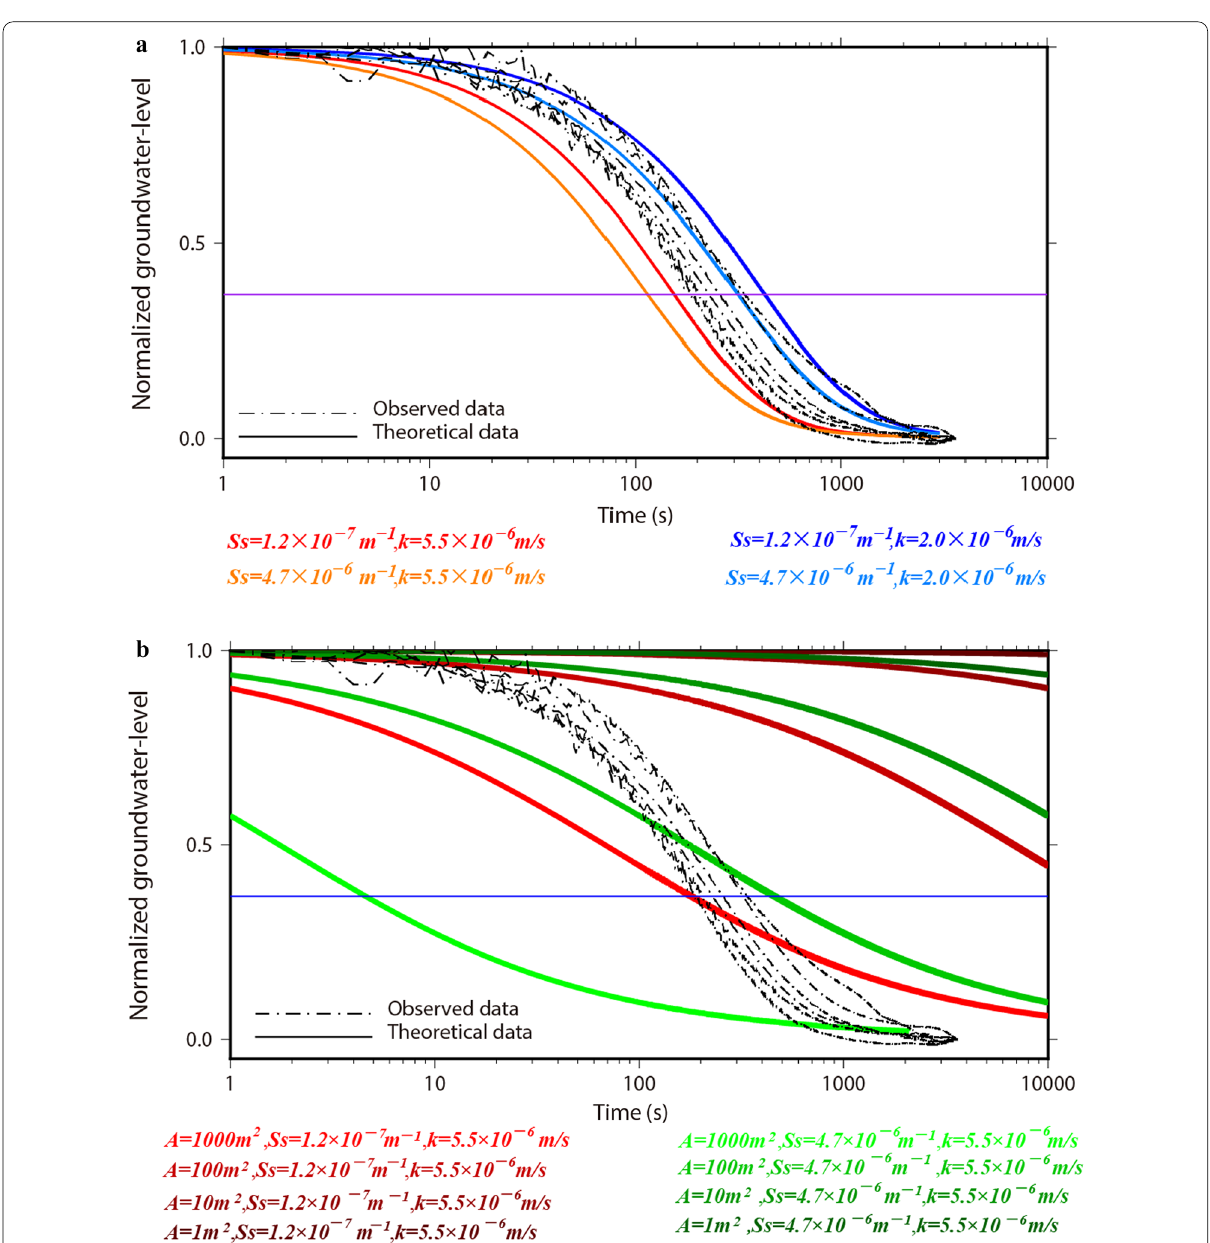
Fig. 7 Slug test model results. a Results of the slug test model for the radial flow case. The one-dot chain lines show the observed data for the target events. The colored solid lines show the theoretical curves which were calculated using Eqs. (4)–(9). The horizontal axis is logarithmic time. The vertical axis is the normalized groundwater level ( h s in Eq. (5)). The purple line indicates 1/e of h s , showing that the time at the intersection with the groundwater is a time constant. b Results of the slug test model for the linear flow case. The one-dot chain lines show the observed data. The colored solid lines show the theoretical curves which were calculated using Eqs. (10)–(13). The horizontal axis is logarithmic time. The vertical axis is the normalized groundwater level ( h s in Eq. (5)). The purple line is the same as